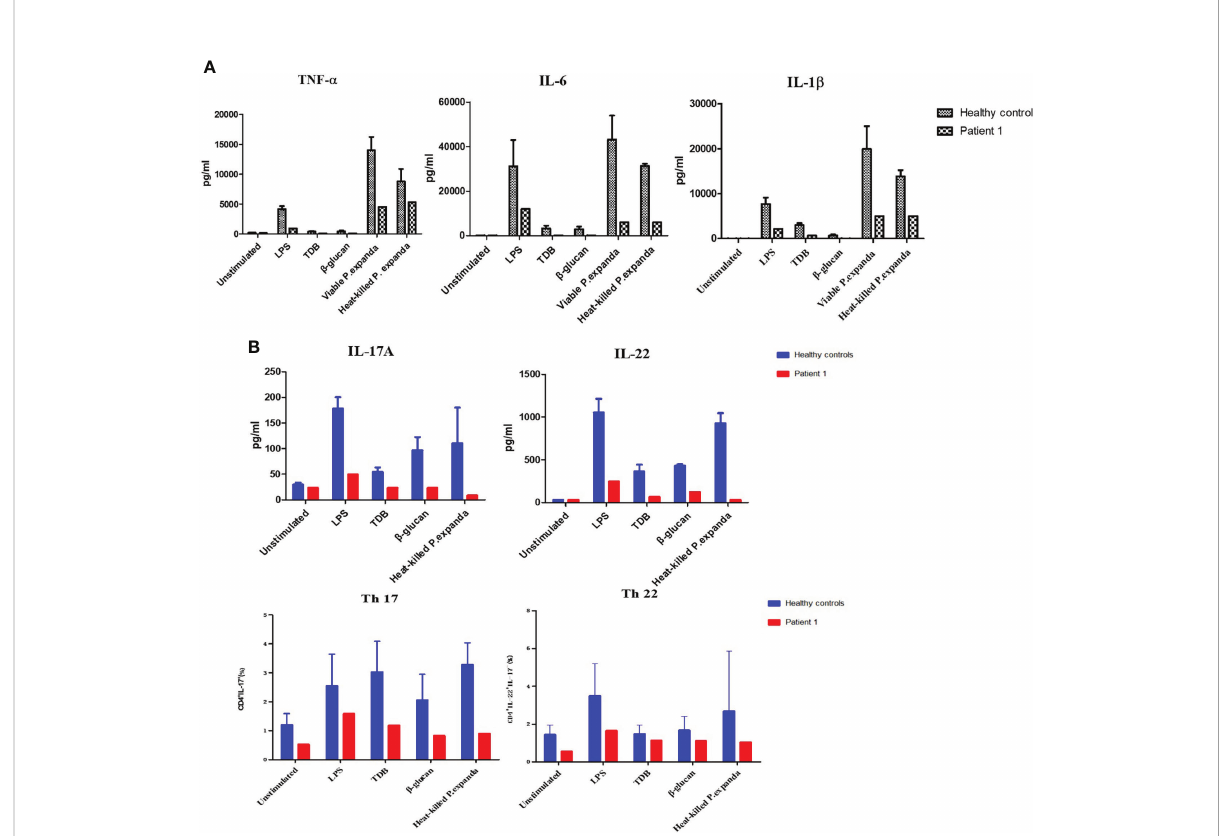
FIGURE 2 Functional studies of patient 1. (A) Detection of natural immune responses in peripheral blood mononuclear cells (PBMCs) separated from the patient and healthy controls (n = 3). Pro ‐ in fl ammatory cytokines production of TNF ‐ a , IL ‐ 6, and IL ‐ 1 b in response to 24 ‐ h stimulations with LPS, TDB, b ‐ glucan, and P. expanda conidia (HK or viable resting) was detected in the supernatants by commercial ELISA kits (B) Detection of acquired immune responses in PBMCs separated from the patient and healthy controls. Cytokine production of IL ‐ 17A, IL-22 in response to LPS, TDB, b ‐ glucan, and P. expanda conidia (HK) stimulations were measured in the cell culture supernatants after 6 days using commercial ELISA kits (n = 3). The proportions of Th17 (IL ‐ 17+CD4+) Th22 (IL ‐ 22+IL ‐ 17 ‐ CD4+) cells in the total number of CD4+ T cells were counted by fl ow cytometry after 6 ‐ day stimulation (n = 6). LPS, lipopolysaccharide; TDB, Trehalose dibehenate; P1, patient1; Th, T helper